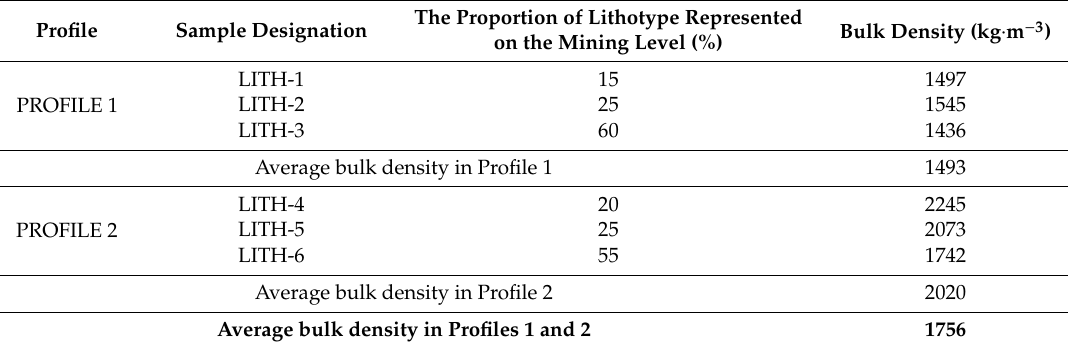
Table 1. Results of laboratory determination of bulk density from LITH 1–LITH 6 point samples from Profile 1 and Profile